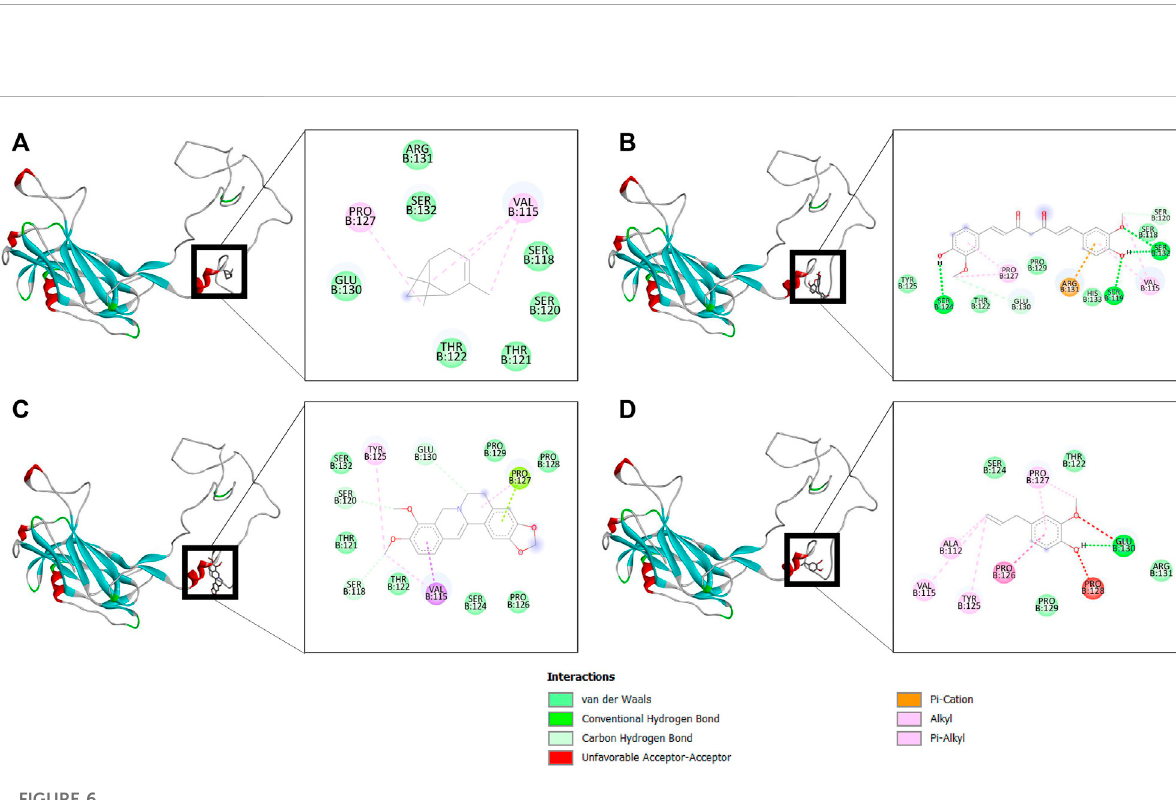
(cid:1) receptor has 4.58 A mean RMSD. RoG de fi nes the compactness distribution (Figure 8A) re fl ected that the inhibitor bound state of the structure, and Figure 8D shows that RoG remained of THR experiences comparatively less structural deviation along (cid:1) consistent for the THR complex in comparison to the THR the simulation time and has 3.22 A mean RMSD, while the THR